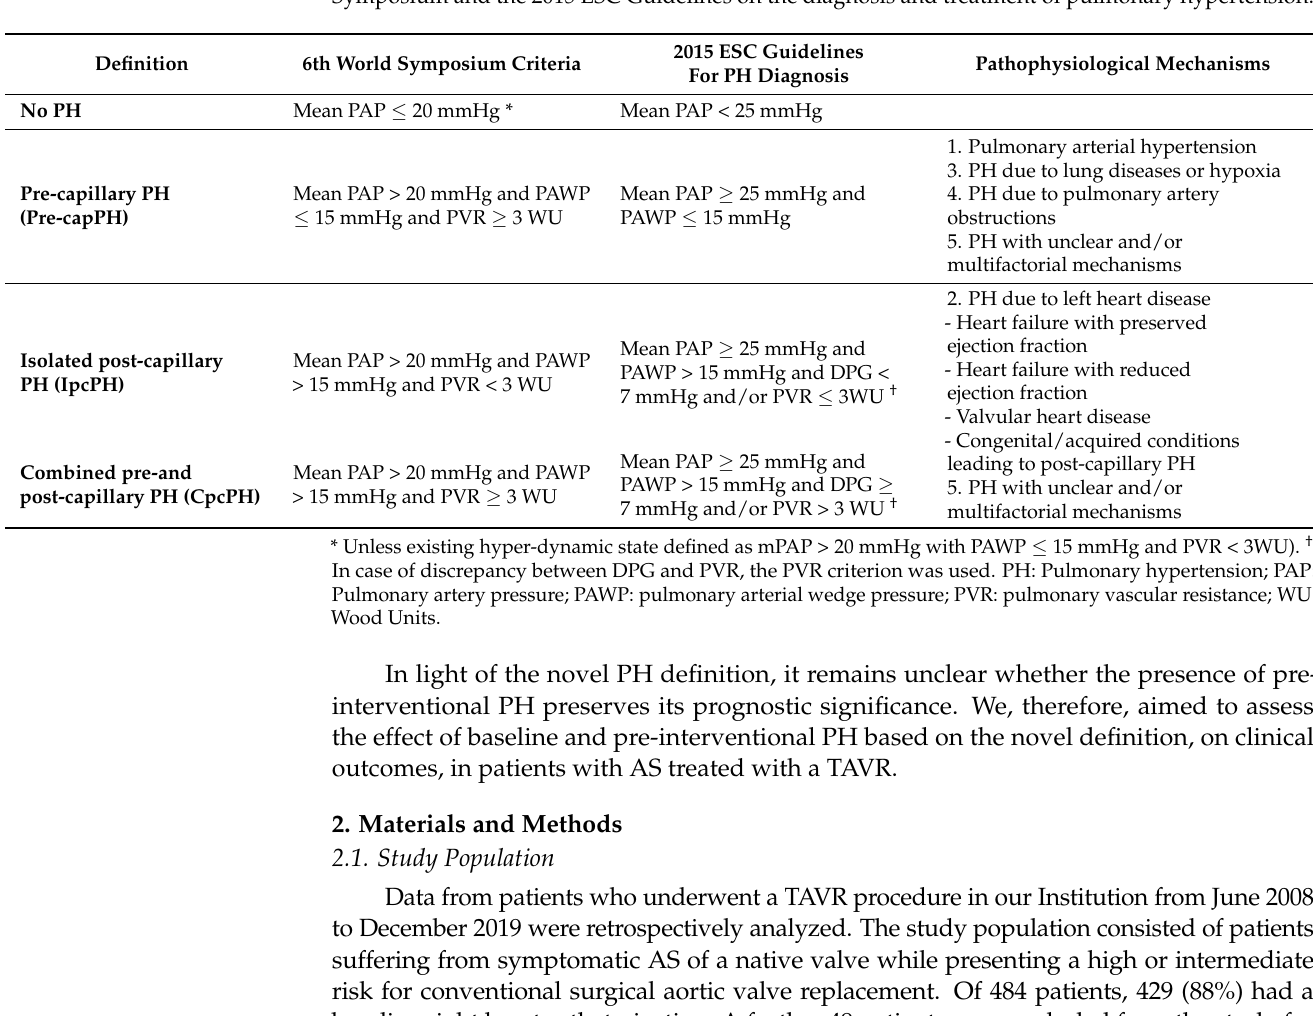
Table 1. PH hemodynamic criteria and definitions according to the Proceedings of the 6th World Symposium and the 2015 ESC Guidelines on the diagnosis and treatment of pulmonary